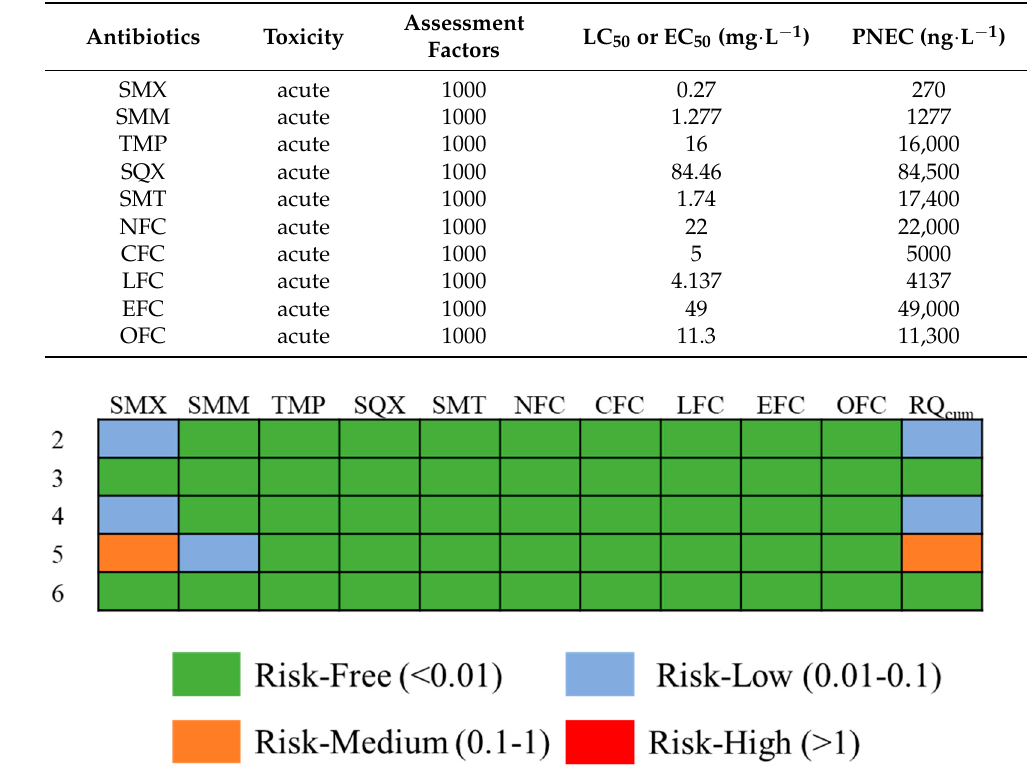
Figure 2. RQ and RQcum of antibiotics in representative water sources.